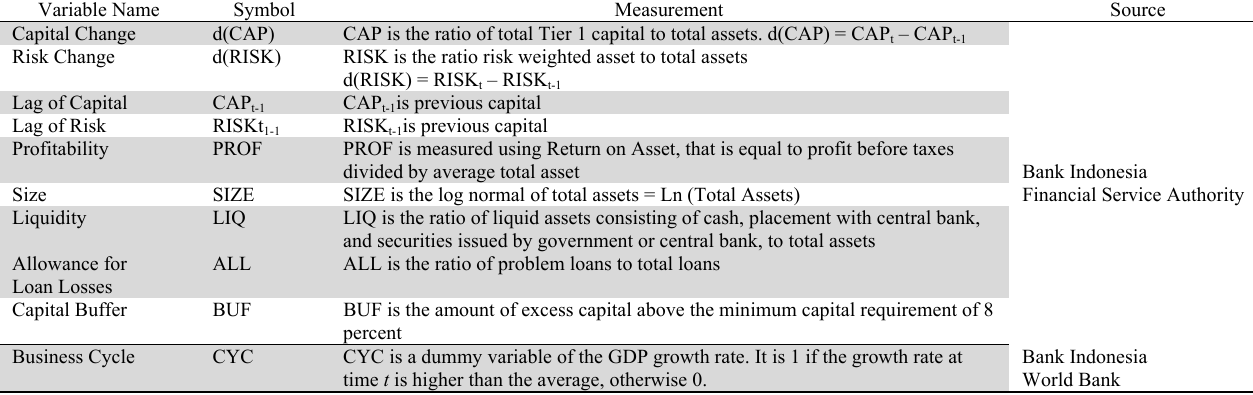
Research Variable, Symbol, Measurement,